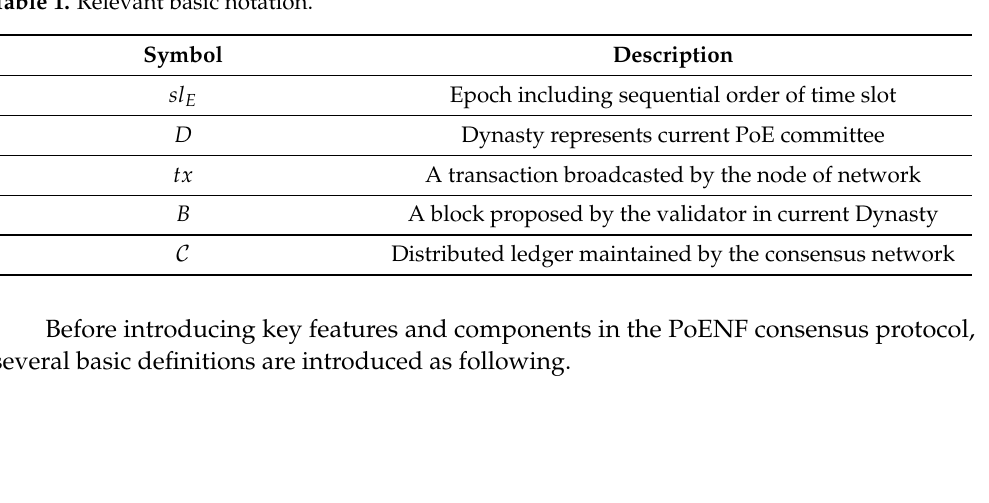
Table 1. Relevant basic